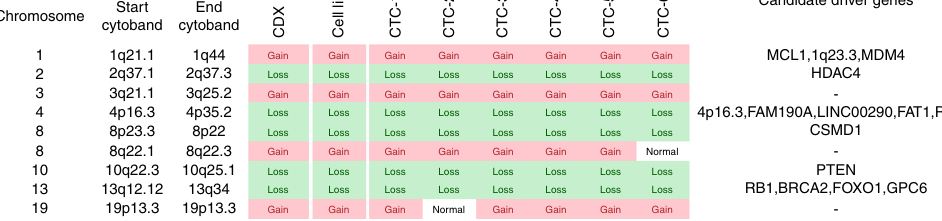
Fig. 5 Genomic analysis of the CDX and the CDX-derived cell line. a Origin of CDX and CDX-derived cell line mutations. Thirty-two (40%) of the 80 mutations detected in the CDX and the cell line arose from PTs. Eleven (14%) mutations arose from CTCs while 37 (46%) were exclusively found in the CDX and the cell line. b Heatmap of the 11 mutations of the CDX and the cell line arising from CTCs. Mutated genes, amino acid change, and mutation status of the eight tumor samples including the CDX, the cell line and six CTC samples are indicated. Red color indicates that sample is mutated, green indicates that sample is not mutated, and white indicates that the position is not covered with suf fi cient depth of sequencing. c Origin of the CDX and CDX- derived cell line CNAs. Five (12%) of the 41 CDX and cell line CNAs arose from PTs via CTCs, 9 (22%) arose from CTCs, and 27 (66%) were exclusively found in the CDX and the cell line. d Heatmap of the nine CDX and CDX-derived cell line CNAs arising from CTCs. Chromosome harboring the CNA, CNA status in the eight tumor samples, and candidate driver genes in chromosome segments are